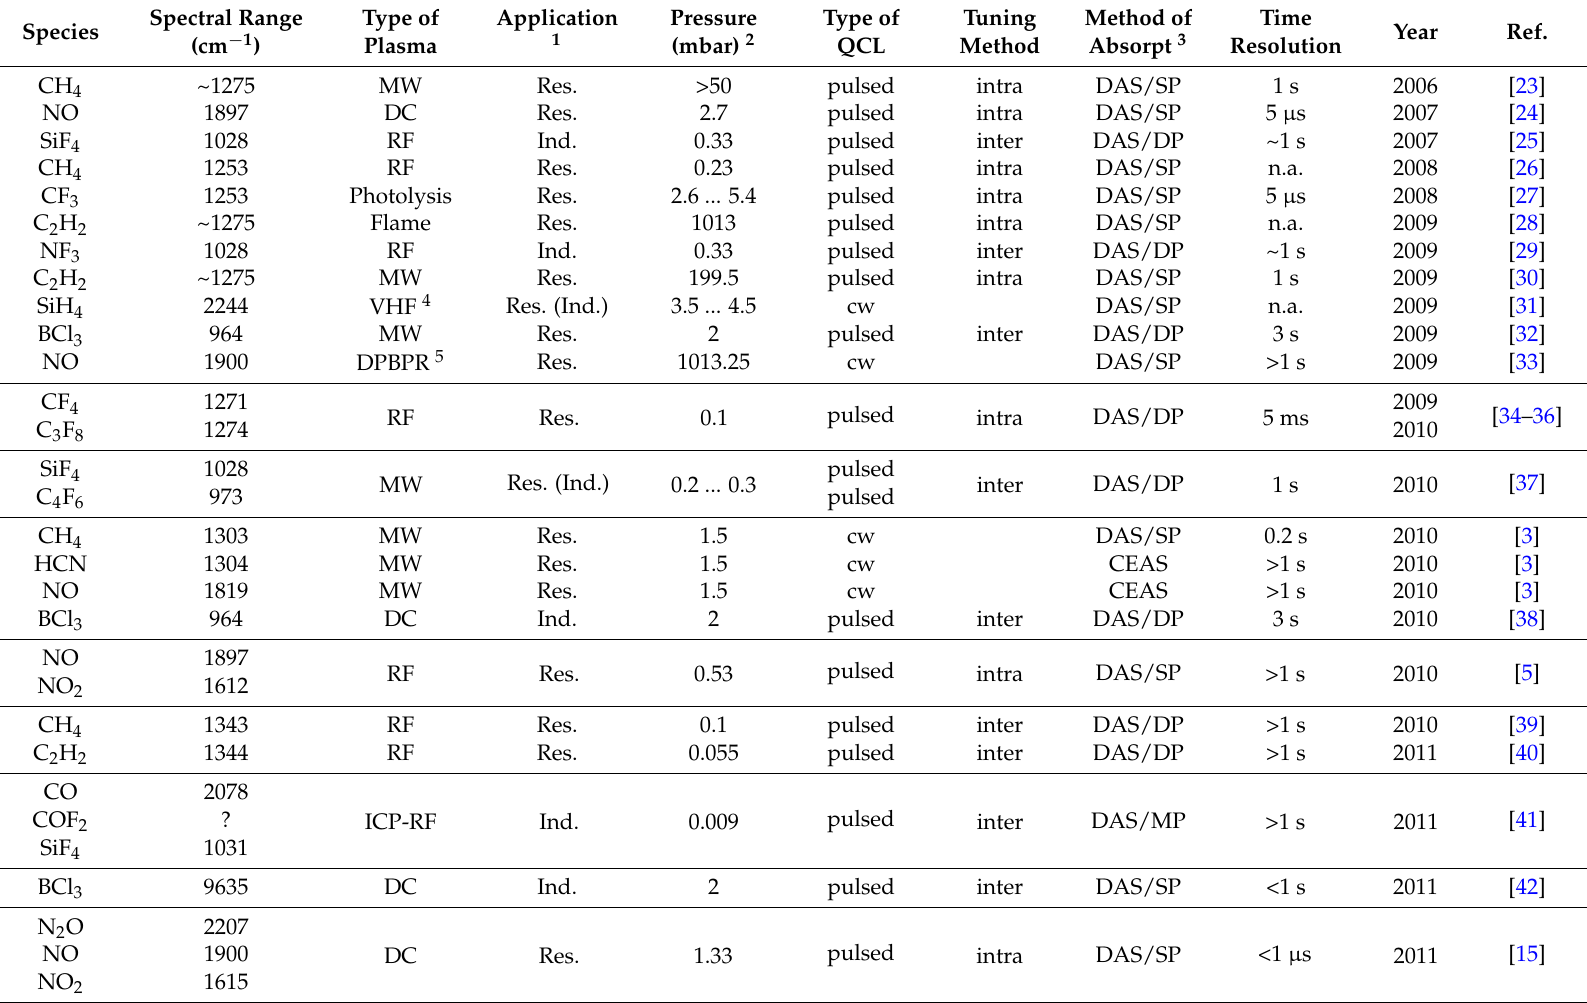
Table 1. Plasma diagnostic applications of mid infrared (MIR) quantum cascade lasers